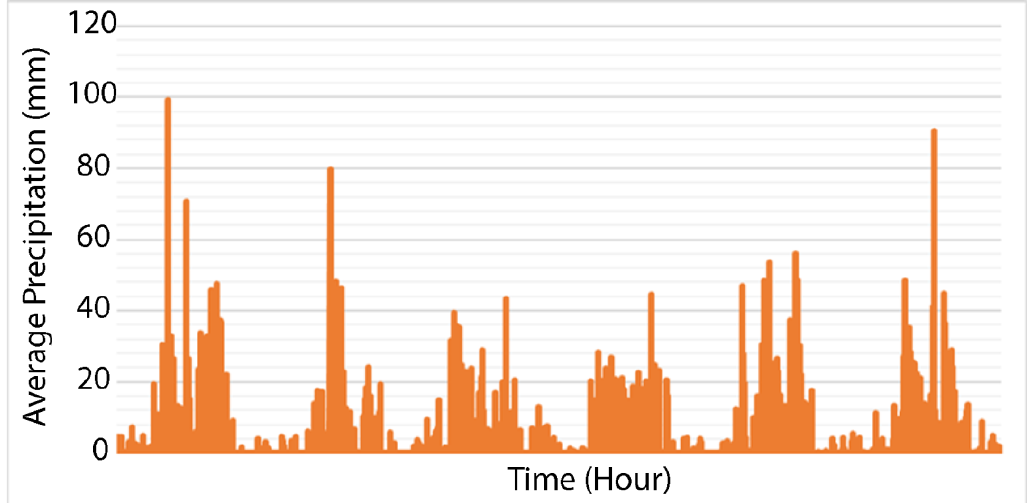
Figure 4. Hourly precipitation, 2010 – 2015.